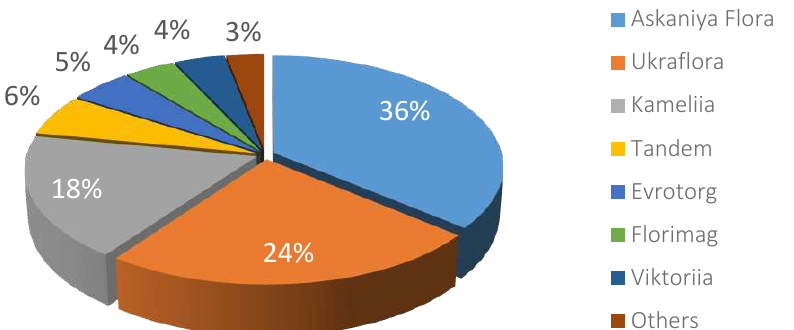
Figure 1. Distribution of market shares on the flower market of Ukraine in 2017